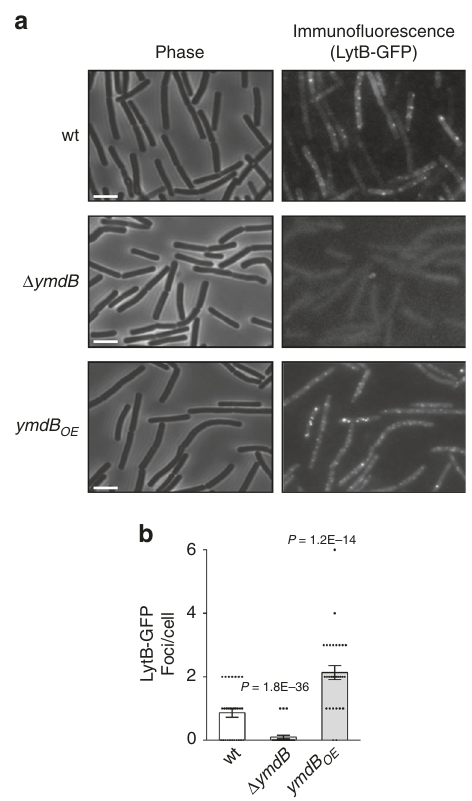
Fig. 2 LyB localizes to the cell surface in YmdB-dependent manner. a , b Bs wt (AB132: lytB-gfp ), Δ ymdB (AB134: lytB-gfp , Δ ymdB ) and ymdB OE (AB144: lytB-gfp , Δ ymdB, amyE ::P hyper-spank -ymdB ) strains were spotted onto poly L - lysine coated coverslips, treated with anti-GFP primary antibodies and FITC-conjugated secondary antibodies and visualized by fl uorescence microscopy. Shown are phase contrast images (left panels) and respective immuno fl uorescence images (right panels). Scale bars represent 2 μ m ( a ). Graph presents quanti fi cation of the average number of LytB-GFP foci displayed per cell. Shown are mean ± SEM and P values (unpaired Student ’ s t test) of at least three independent experiments ( n cells = 600) ( b ). Source data are provided as a Source Data fi